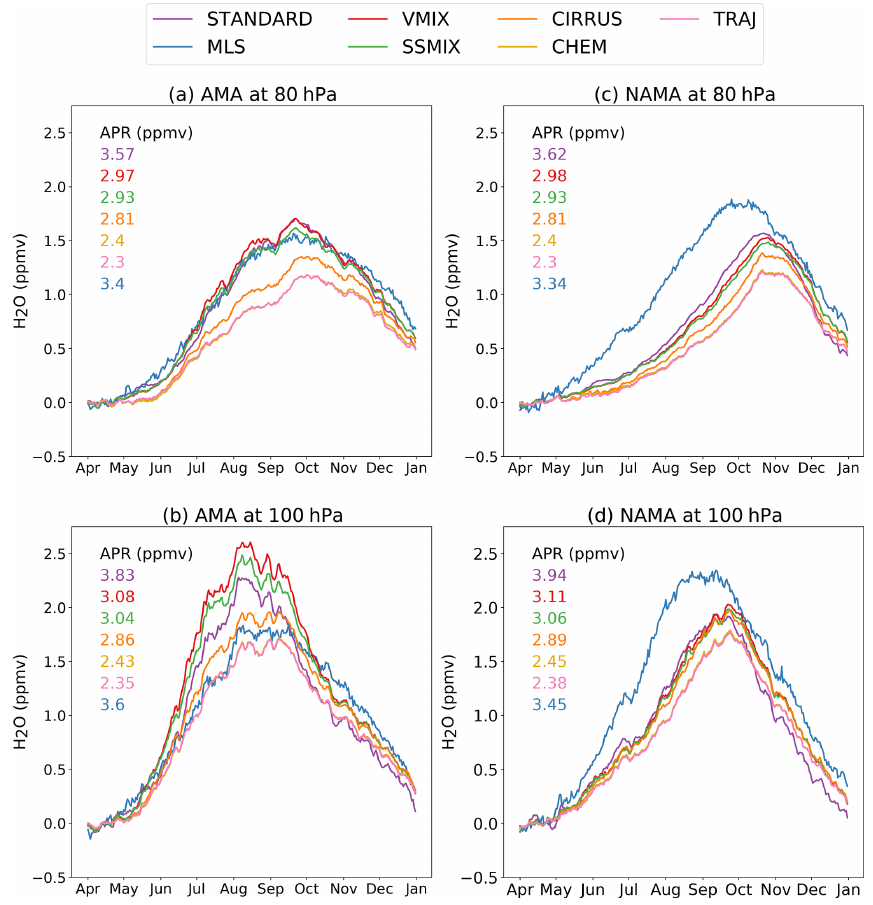
Figure 4. Amplitude of the cycle of daily water vapour at (a, c) 80hPa and (b, d) 100hPa averaged over (a, b) the Asian Monsoon Anticy- clone, AMA (20–40 ◦ N, 40–140 ◦ E), and (c, d) the North American Monsoon Anticyclone, NAMA (10–30 ◦ N, 220–300 ◦ E), for the period 2007–2016. Coloured numbers are the mean water vapour during April in each experiment, which is used as the reference level. The regions in which averages are computed correspond to the maxima of water vapour found in the boreal summer climatology of the water vapour observed by Aura MLS